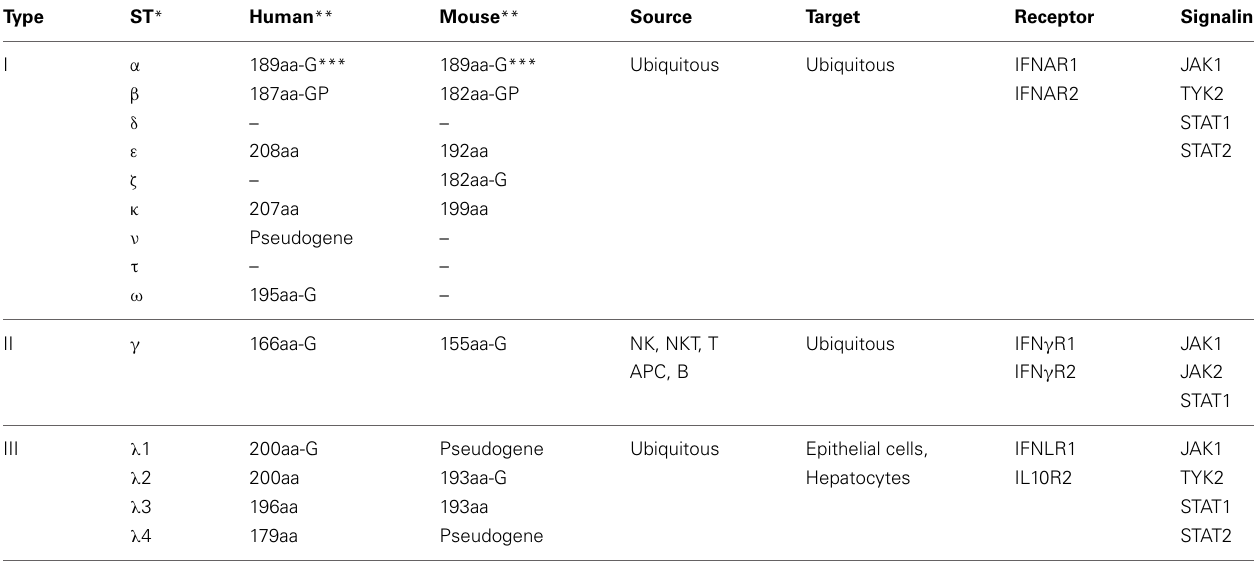
Table 1 | The interferon